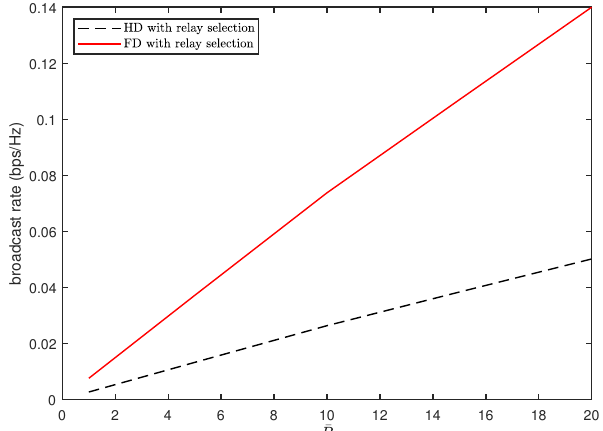
Figure 3. Comparison of broadcast rates as a function of ¯ P ( d =